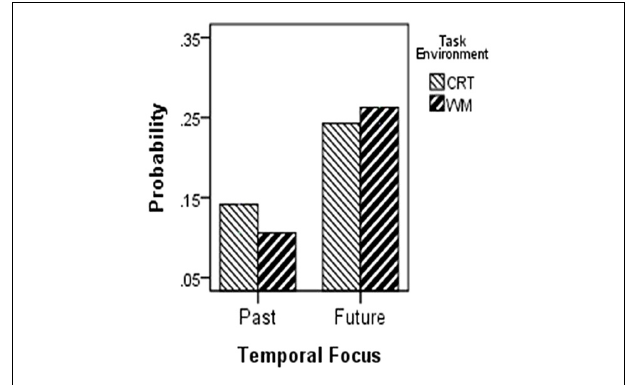
FIGURE 3 | 2 (temporal focus: past, future) × 2 (task environment: CRT, WMT) repeatedANOVA.